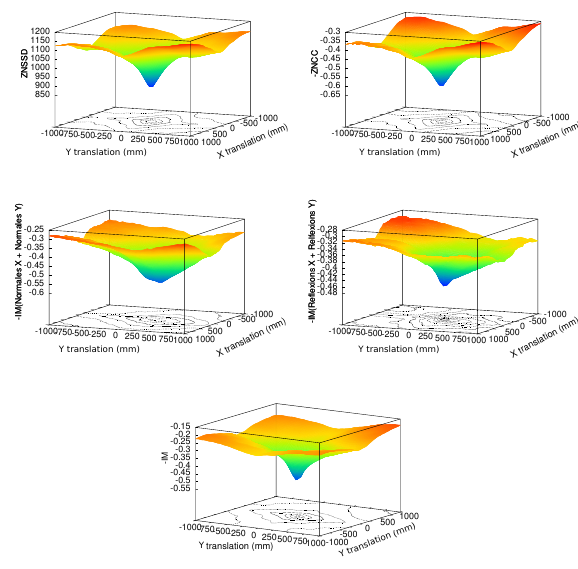
Figure 3: Example of cost functions for five correlation